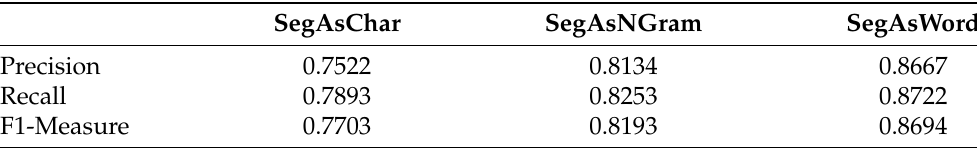
Table 2. The evaluation of the payload segmentation